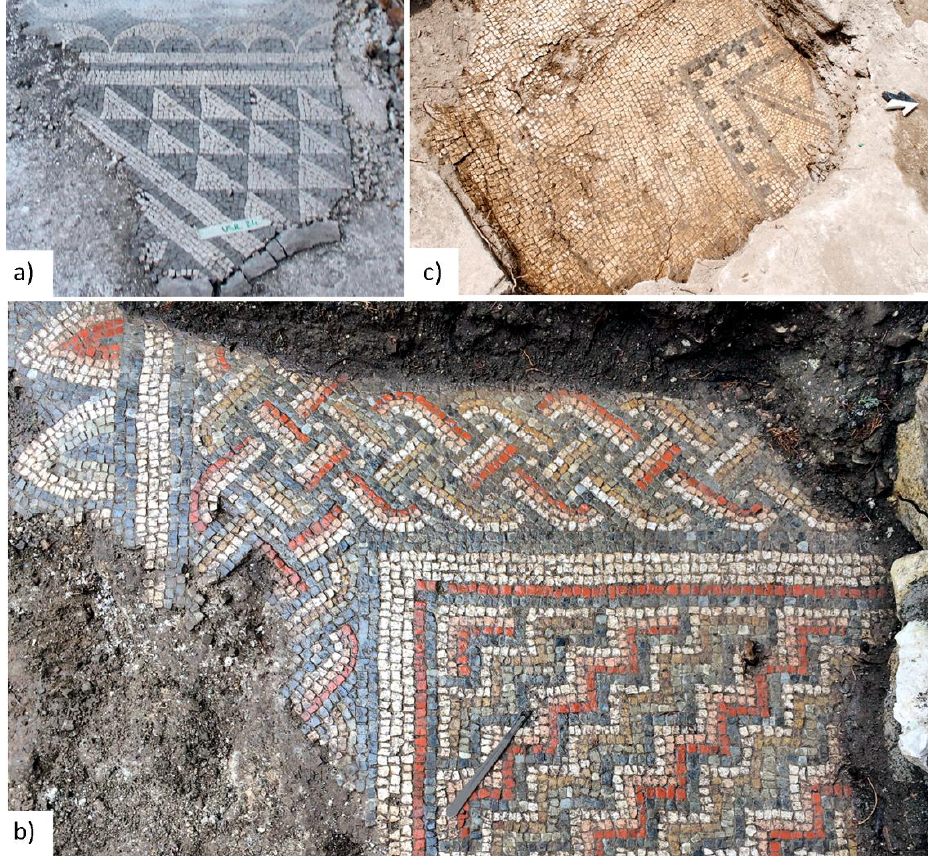
Figure 4. ( a ) Domus 1, black and white mosaic in Room 13; ( b ) Domus 2a, polychrome mosaic, par- tially uncovered, in Room 22; and ( c ) Domus 2a, black and white mosaic in Room